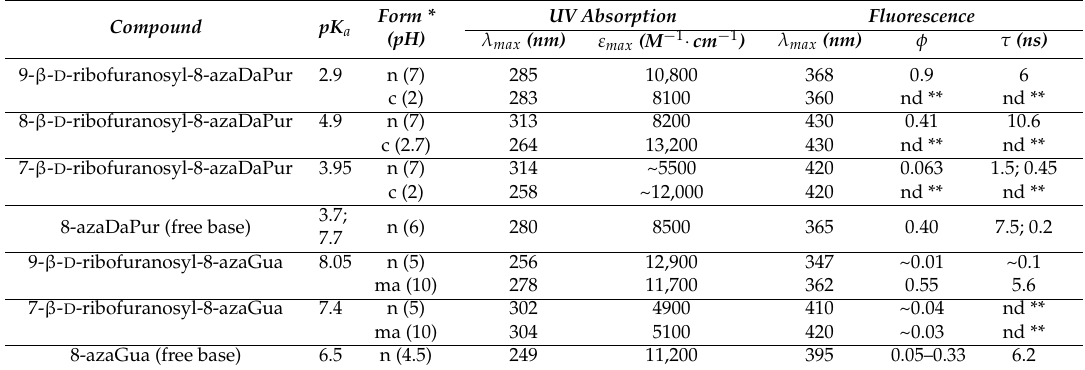
Table 3. Ionization constants (pK a values) and spectral parameters for neutral and ionic forms of the selected 8-azapurine ribosides and free bases. The UV spectral data are compiled from the literature [11,18,20] and fluorescence parameters determined in this and previous [11,15] works.